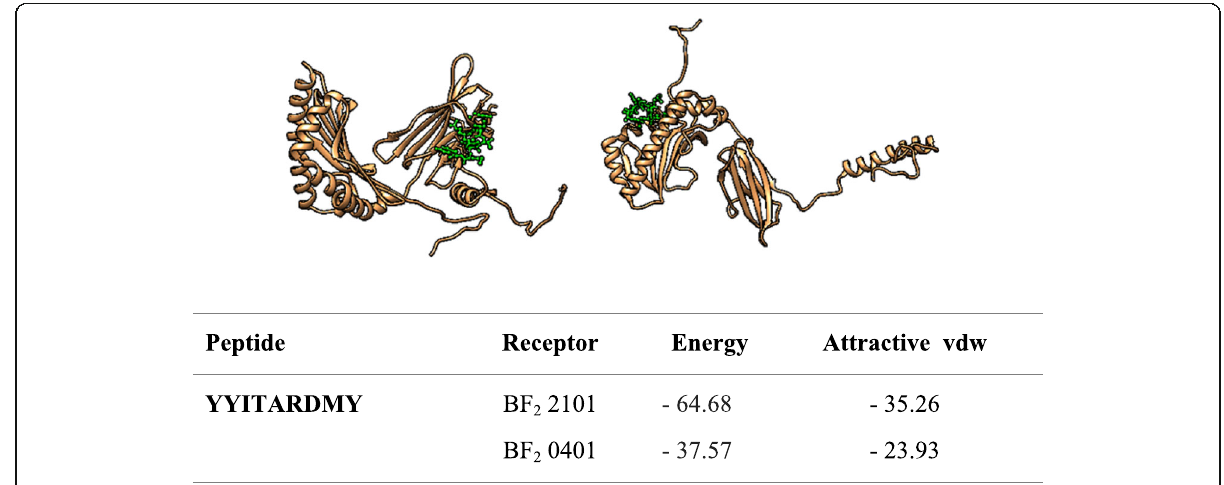
Fig. 8 Docking of YYITARDMY with BF 2